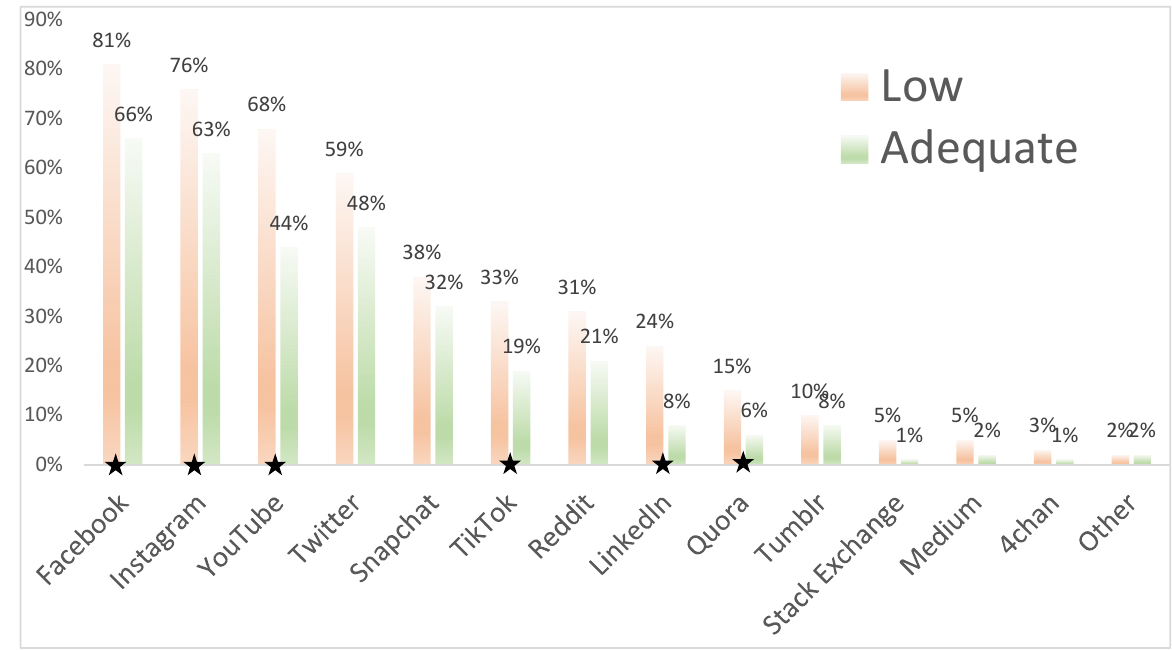
Figure 1. COVID-19 health information sources by health literacy. * Use of Facebook, Instagram, YouTube, TikTok, LinkedIn, and Quora all varied significantly at p < 0.05.